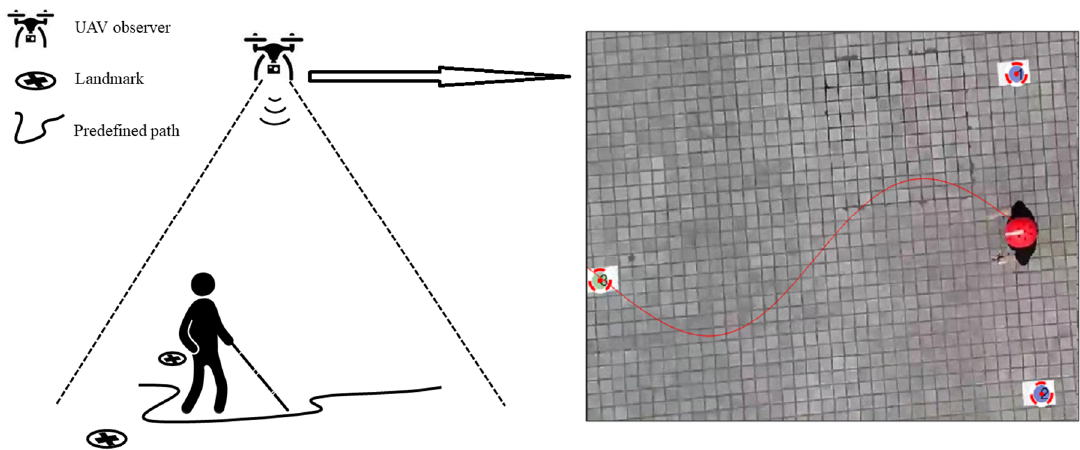
Figure 13. Field test scene. Left, an overlook mode unmanned aerial vehicle (UAV) is used to capture and transmit the positioning status of the participant and landmarks to the server to calculate the guiding direction. Right, the image from the UAV camera is shown, in addition to the auto-marked landmarks and the predefined path.